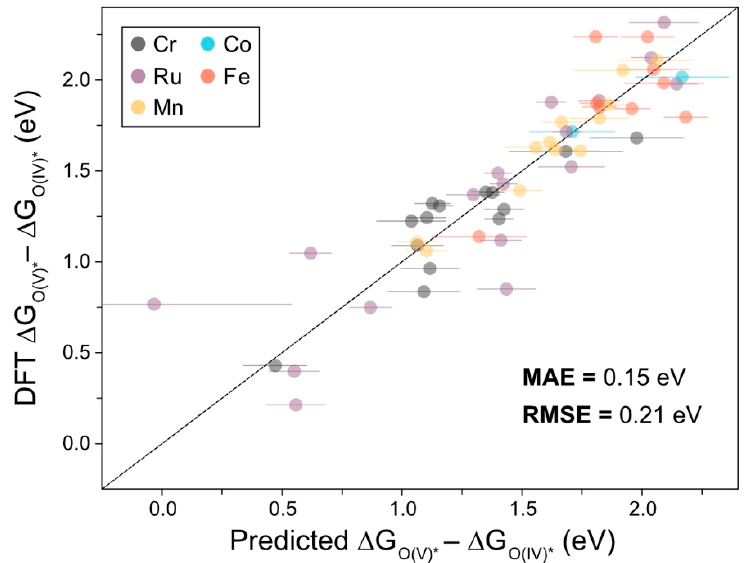
Figure 4. Parity plot for the LOOCV predictions of Δ(cid:1833) (cid:3016)((cid:3023)) ∗ − Δ(cid:1833) (cid:3016)((cid:3010)(cid:3023)) ∗ for a subset of catalysts which were considered in Figure 2a, with MAE and RMSE values shown.